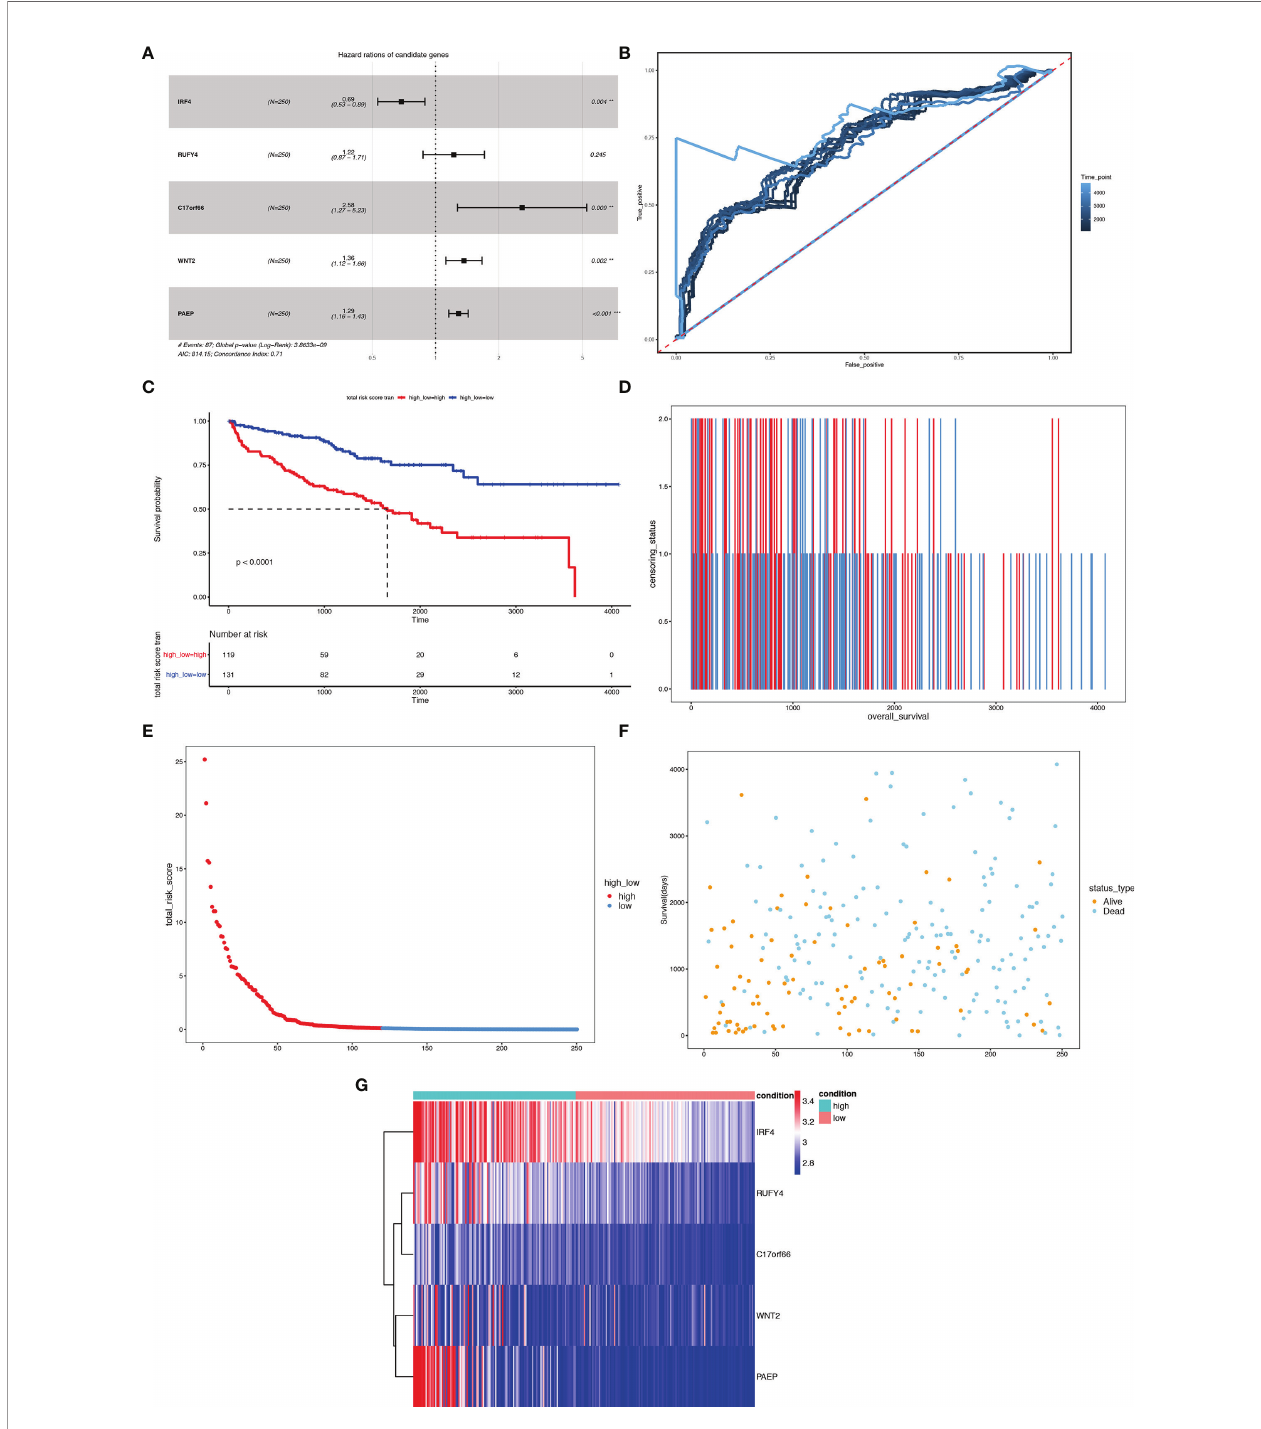
FIGURE 14 | Risk score analysis of the 5-gene signature-based prognostic model in the training group ccRCC patients. (A) Five-gene multivariate prognosis model for training group ccRCC patients. (B) Time dependent ROC curve analysis exhibits the prognostic performance of the fi ve differentially expressed gene signature- based prognostic model in predicting 1 – 5-year survival times of the training group ccRCC patients in the TCGA-KIRC cohort. (C) Kaplan – Meier curve shows the overall survival of high- and low-risk ccRCC patients in the TCGA-KIRC cohort. (D – F ) Survival bar, risk curve, and survival scatter plot analysis show surviving status of patients of high- and low-risk. (G) Heat maps of expression pro fi les of 5 genes obtained using multivariate Cox regression. **P < 0.01, ***p <